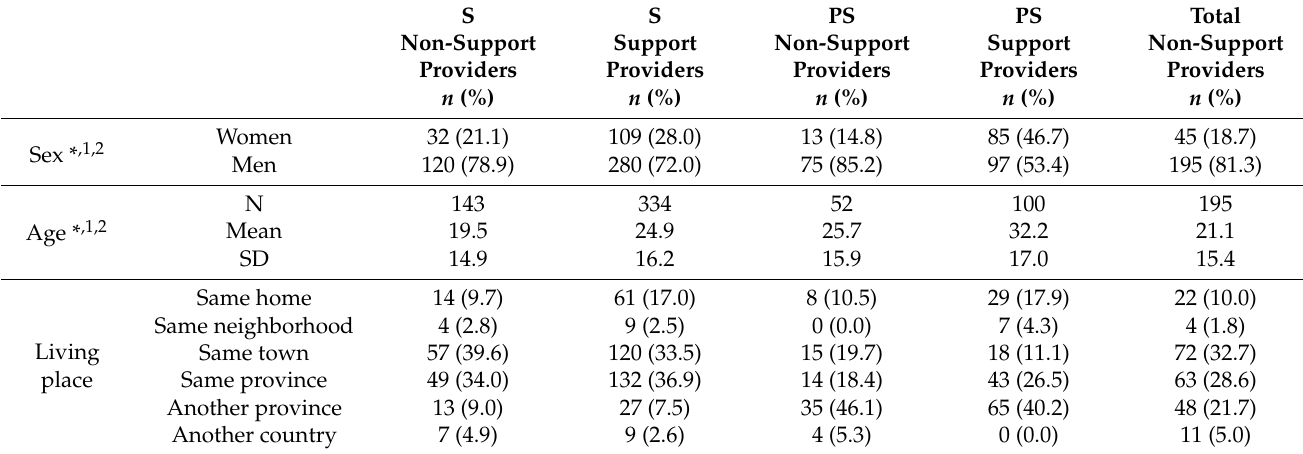
Table 4. Providers and non-support providers by